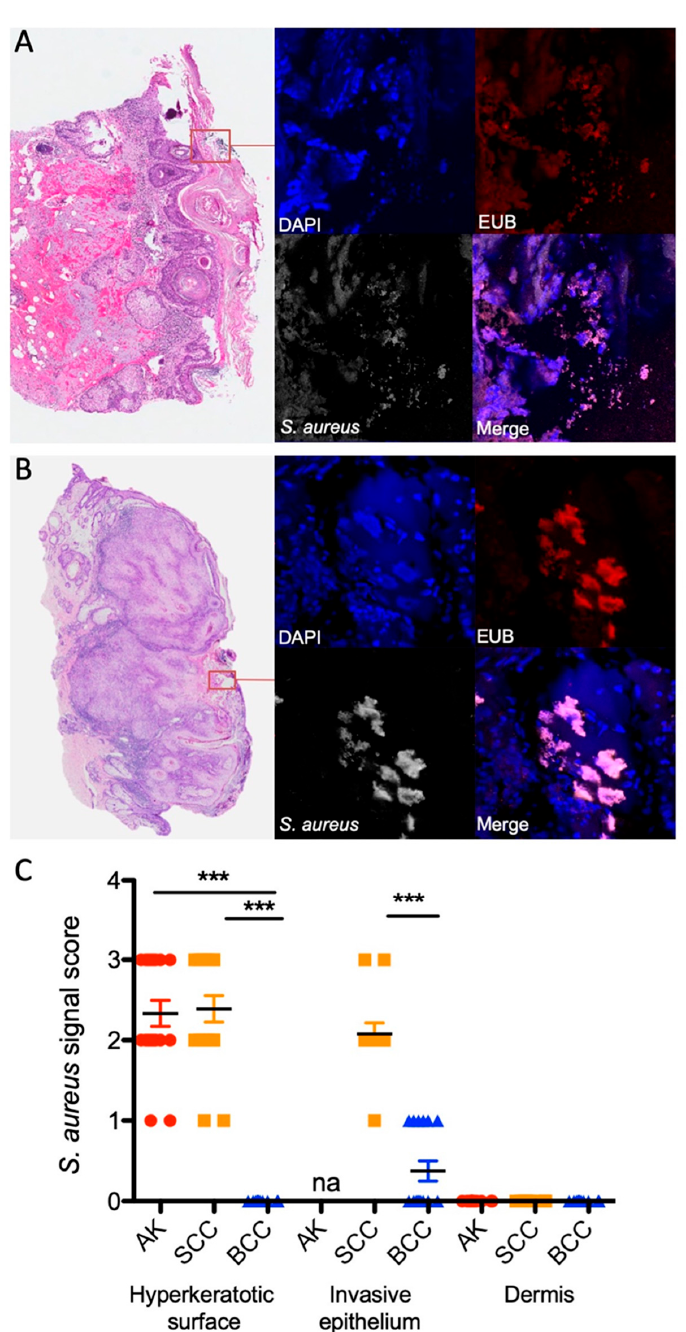
Figure 4. S. aureus is associated with hyperkeratotic areas in AK and SCC and invasive tumor in SCC. In situ visualization of S. aureus in the hyperkeratotic layer in AK ( A ) and SCC ( B ) using FISH (DAPI: blue, EUB338: red; S. aureus : grey; magnification 650×). Representative samples are shown (left: H&E stain; right: FISH). ( C ) Semi-quantitative scoring of S. aureus specific signals in hyperkeratotic surface areas and invasive tumor areas in a sub-set of specimens (*** p < 0.005; Kruskal Wallis; na, not applicable; AK, n = 5; SCC, n = 5; BCC, n = 5).